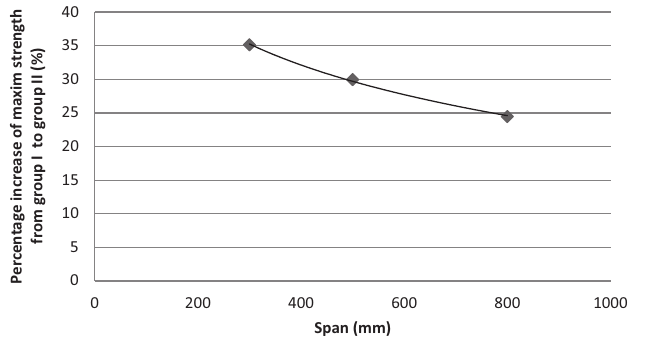
Percentage increase of maxim strength comparing group I to group II according to span